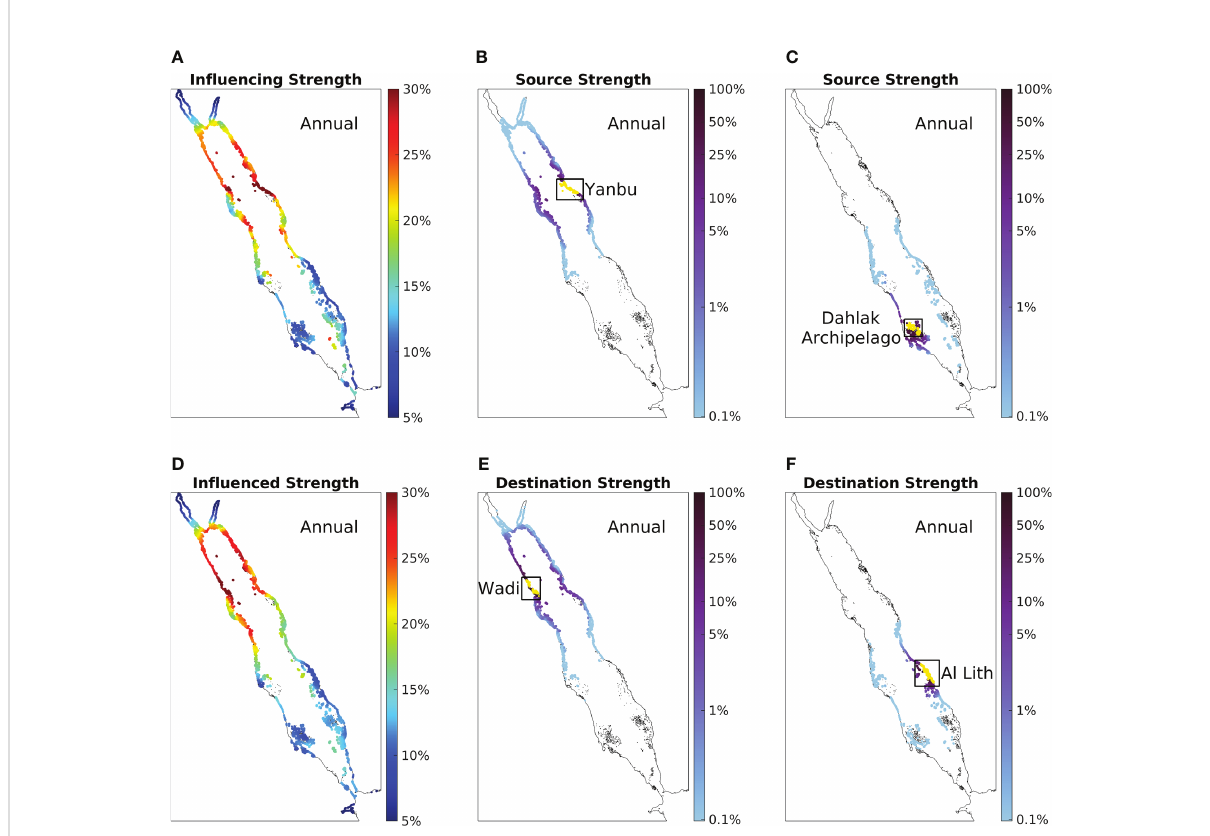
FIGURE 3 The annual physical connectivity atlas of the Red Sea coral reefs. Both (A) annual in fl uencing strength and (D) annual in fl uenced strength are calculated based on the 30-day simulation time and averaged over 13 simulation years. Colours indicate the percentage of connected coral reefs, where a higher value implies that the reef site is a better source (in A) or destination (in D) for all Red Sea reefs. We highlighted a high- value area and a low-value area in both (A, D) as four case studies shown in (B, C , E, F) . (B) Annual source strength of the high- in fl uencing- strength -value area Yanbu. (C) Annual source strength of the low- in fl uencing-strength -value area Dahlak. Colours indicate the level of connection, where higher values imply that particles released from Yanbu/Dahlak (marked in yellow) are more likely to reach the reef sites within the 30-day simulation time (blank sites indicate no connections). (E) Annual destination strength of the high- in fl uenced-strength -value area Wadi. (F) Annual destination strength of the low- in fl uenced-strength -value area Al Lith. In contrast, colours also indicate the level of connection, yet higher values imply that particles released from the reef sites are more likely to reach Wadi/Al Lith (marked in yellow). Note the logarithmic scale of the